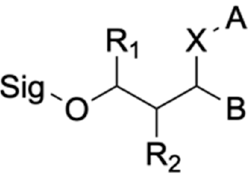
Figure 11. Chemical structure of the Boolean substrate, where A is cleaved by the first hydrolytic enzyme, B is cleaved via second hydrolytic enzyme and Sig is eventually released via a non-hydrolytic enzyme.